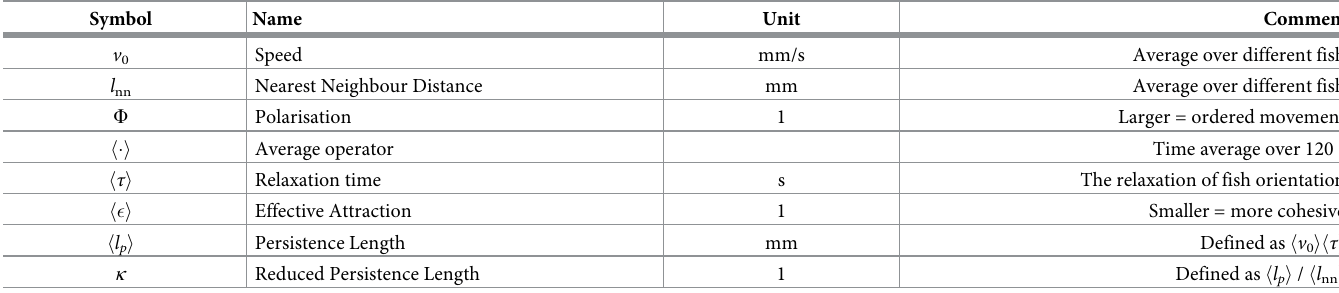
Table 1. A summary of the variables used to describe the fish